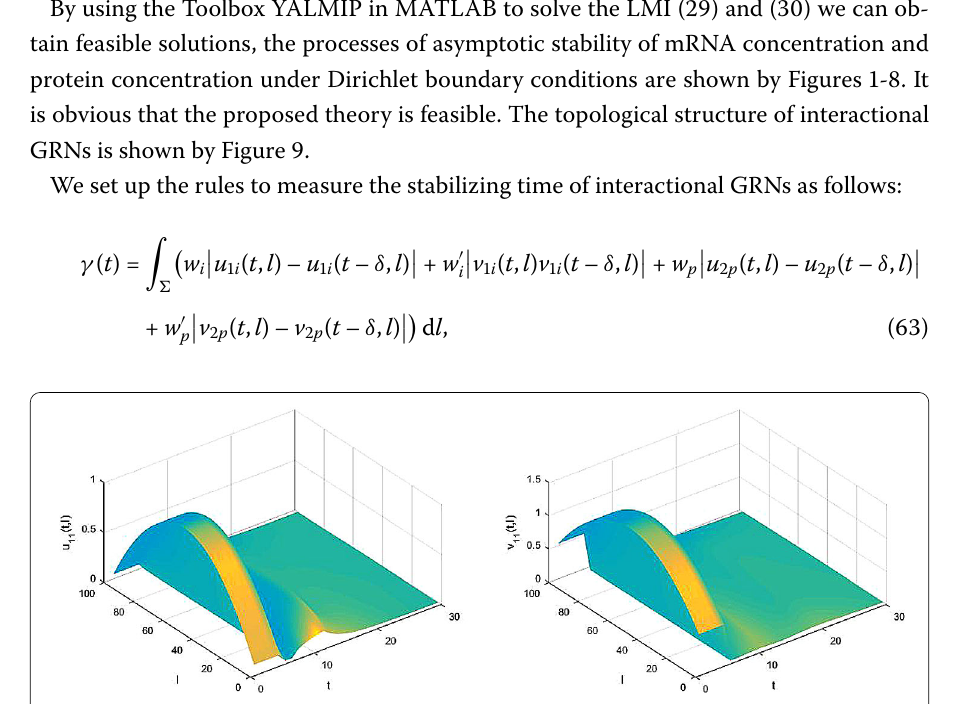
Figure 1 The trajectory of u 11 ( t , l ) and v 11 ( t , l